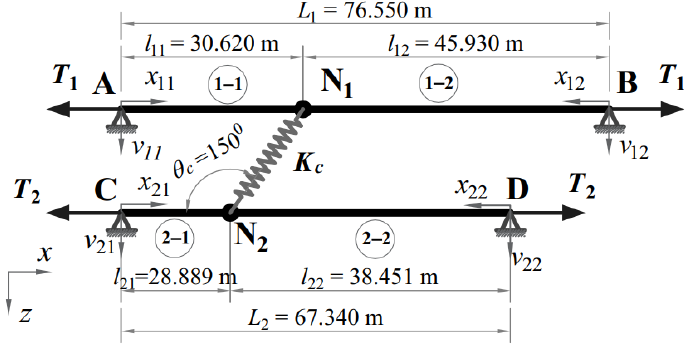
Figure 6. Cable network’s configuration with hinged-end supports. Table 1. Measured frequencies of the cable network with hinged-end support determined by ABAQUS.